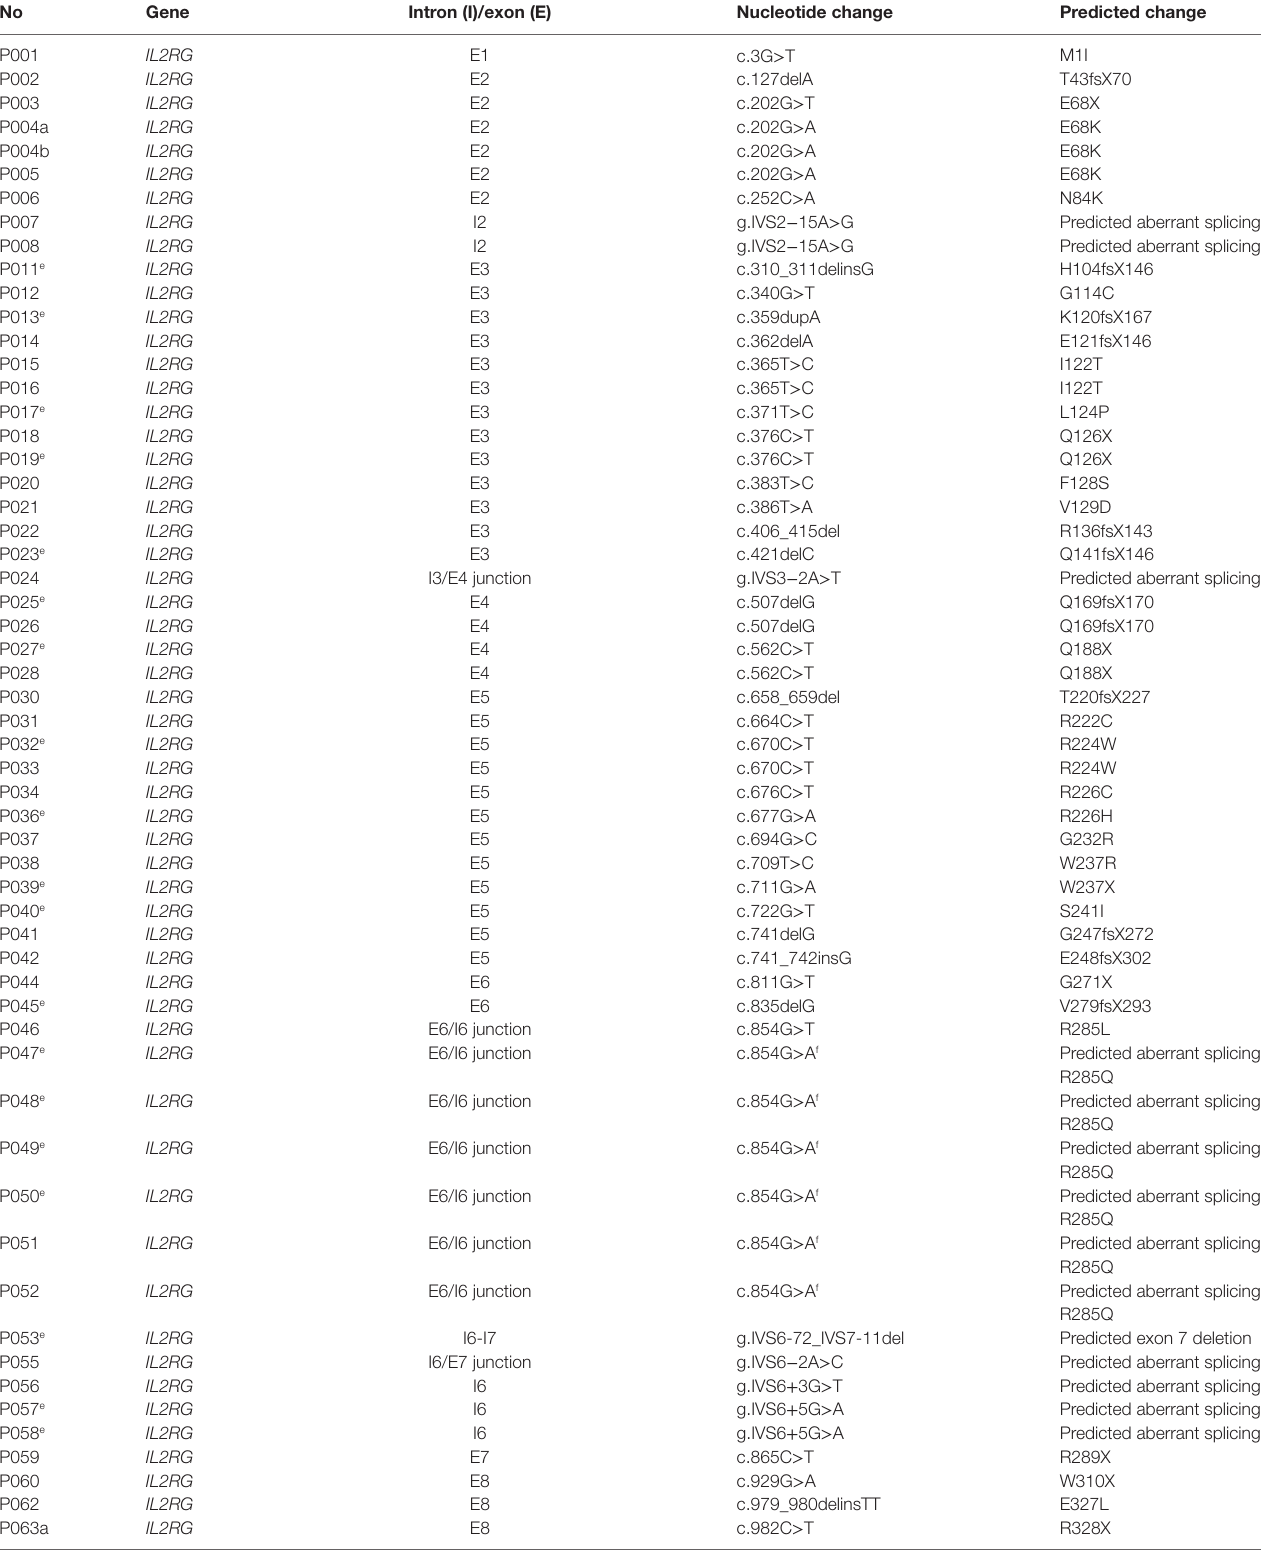
TaBle 1 | Genetic mutations of SCID patients ( n =